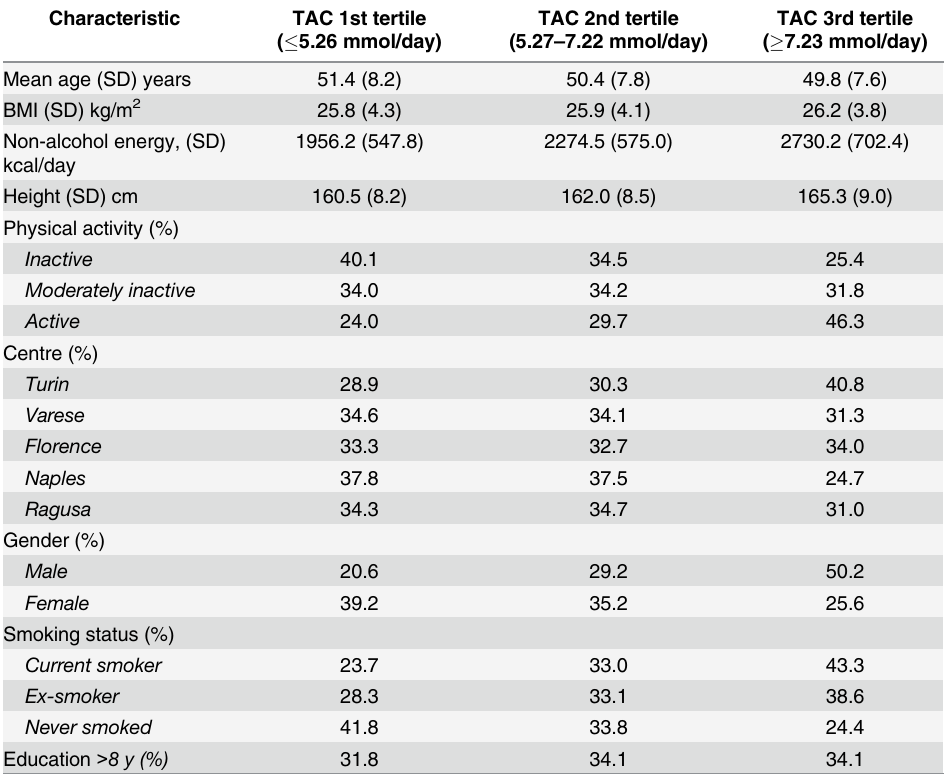
Table 1. Baseline characteristics of study participants by tertile of dietary TAC intake.